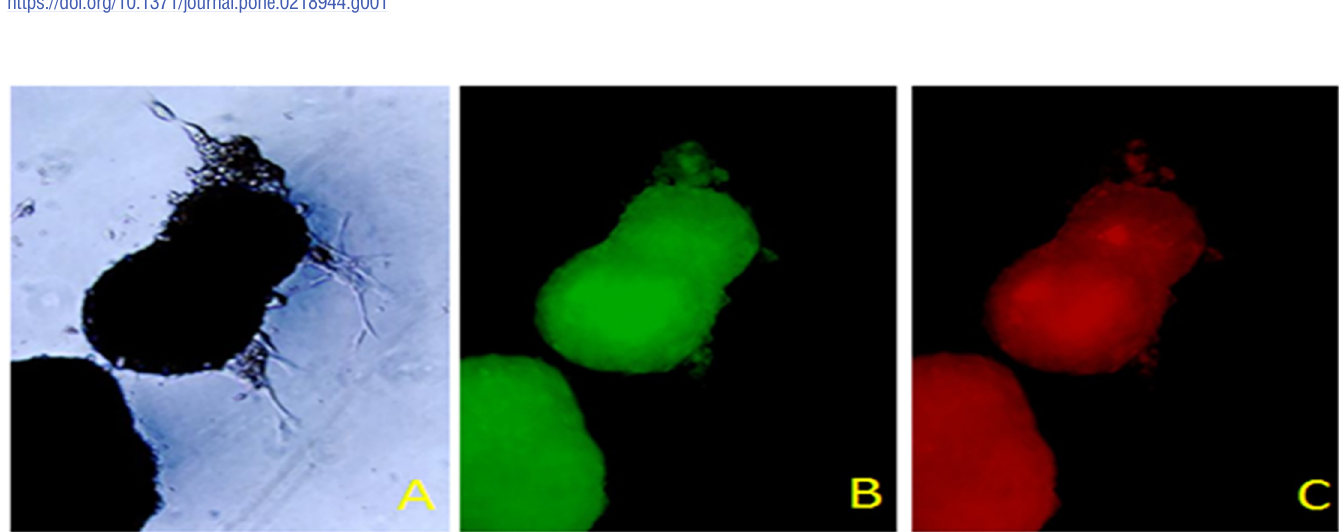
Fig 2. Serum deprived mesenchymal stem cells form embryoid bodies. Embryoid bodies (2A-C) express FoxP3 (green,2B; 10X mag) and CCR8 (red,2C; 10X mag) following serum removal.